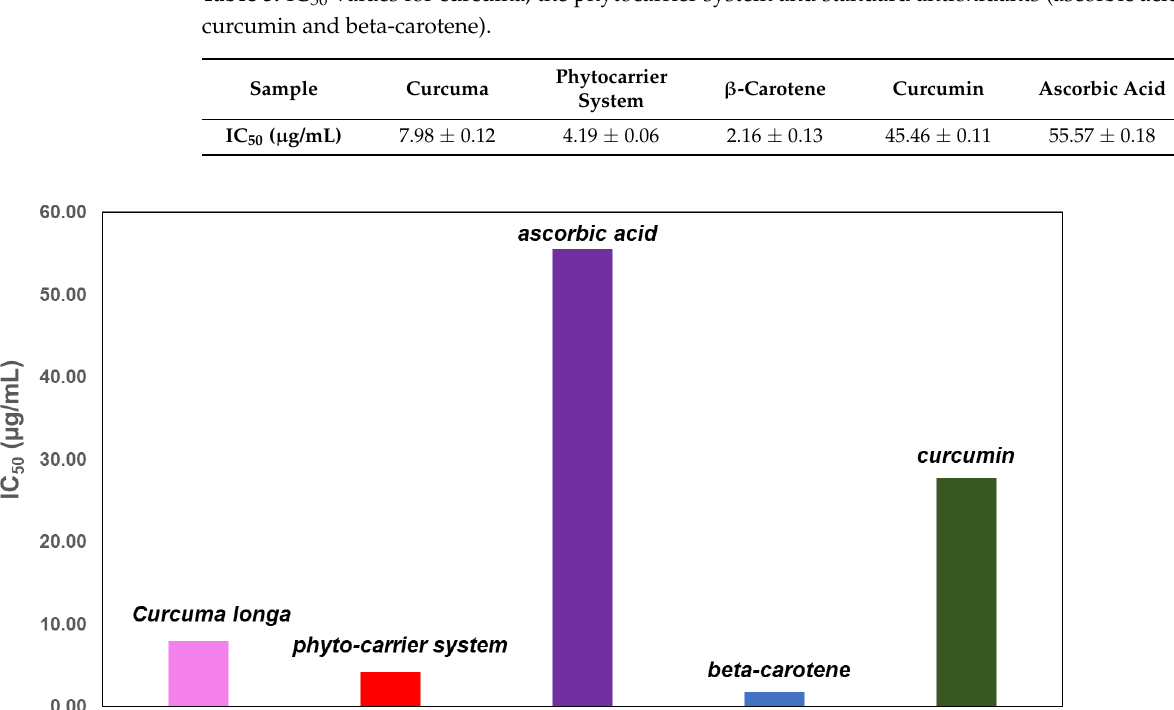
Figure 17. Graphic representation of DPPH results expressed as IC 50 (µg/mL). Based on the obtained IC 50 values and given that lower IC 50 values correspond to higher antioxidant activity, the new phytocarrier system has higher antioxidant activity than that of curcuma, ascorbic acid and curcumin but lower than antioxidant activity than that of the beta-carotene standard. Research has shown that the polarity of solvents significantly influences not only the extraction yield but also their capacity for antioxidant activity [81]. Therefore, only the beta-carotene solvent differed from that of the other samples (cur- cuma, curcumin, ascorbic acid and the phytocarrier system). Thus, a mixture of solvents with varying polarities (methanol-dichloromethane) was used, owing to its poor solubil- ity in methanol, which can explain the obtained IC 50 value of beta-carotene. 3.14. Folin – Ciocalteu Assay The Folin – Ciocalteu assay measures the reducing capacity of an antioxidant based on electron transfer and is considered one of the most accessible and facile methods for evaluation of the total phenolic content (TPC) of a particular substrate [46,54,162,163]. The total polyphenolic content (TPC) of the phytocarrier system and the curcuma sample was determined; the obtained results are presented in Table 6. Table 6. Total polyphenolic content in curcuma and the phytocarrier system. Sample Total Phenolic Content (µg/mL) phytocarrier system 127.47 ± 0.03 Curcuma longa 76.02 ± 0.06 According to the obtained data, the total polyphenolic content detected in the case of the new phytocarrier system is more than 50% higher than that of the curcuma sample. The higher antioxidant capacity of the phytocarrier system compared to the curcuma sample can be attributed to the synergistic action of AgNPs, with a catalytic role played by curcuma polyphenolic compounds [164,165]. 3.15. Cyclic Voltammetry The cyclic voltammetry method provides electrochemical measurements of antioxidant characteristics using a redox-based mechanism to determine total antioxidant capacity. This method is reliable, fast, simple and cost-efficient, providing affordable and accurate information on the reducing capacity of active components [52,54,166,167]